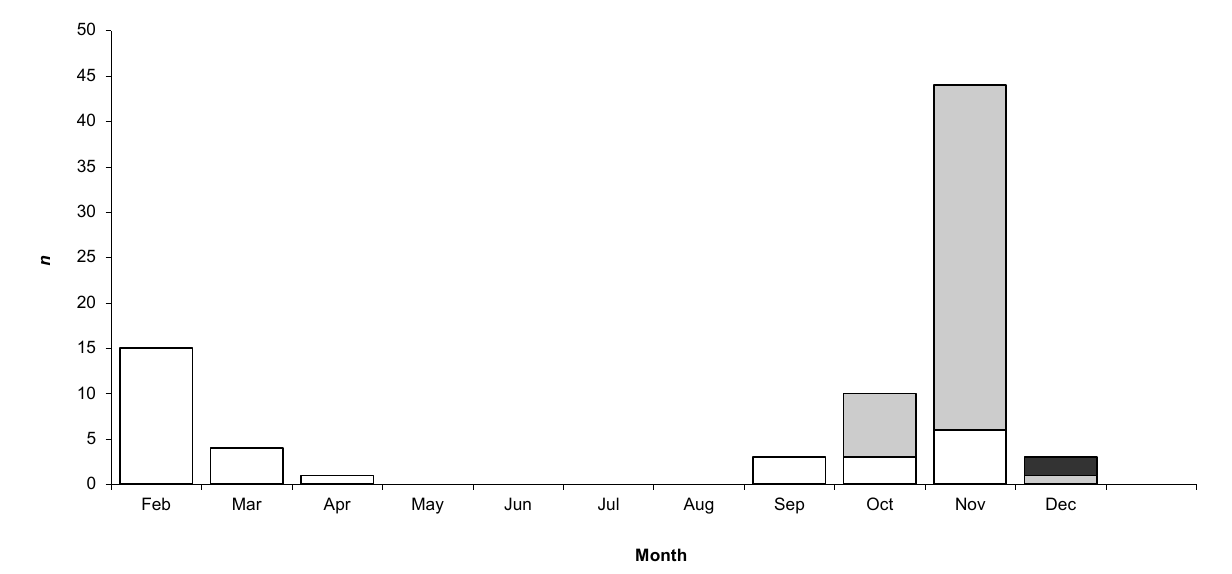
Figure 3. Reproductive activity for Euastacus sulcatus females above the minimum size at egg bearing (OCL 51.5 mm), by month of capture: without eggs or juveniles (white); carrying eggs (grey); and (iii) carrying juveniles